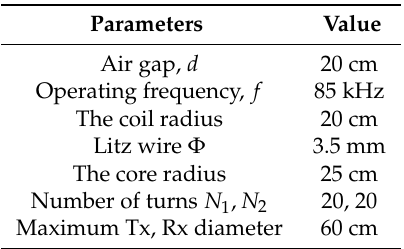
Figure 7. Pads structure and three proposed core types: ( a ) Tx and Rx configuration; ( b ) pot core; ( c ) slotted core; ( d ) shaped bars. Table 1. The simulation